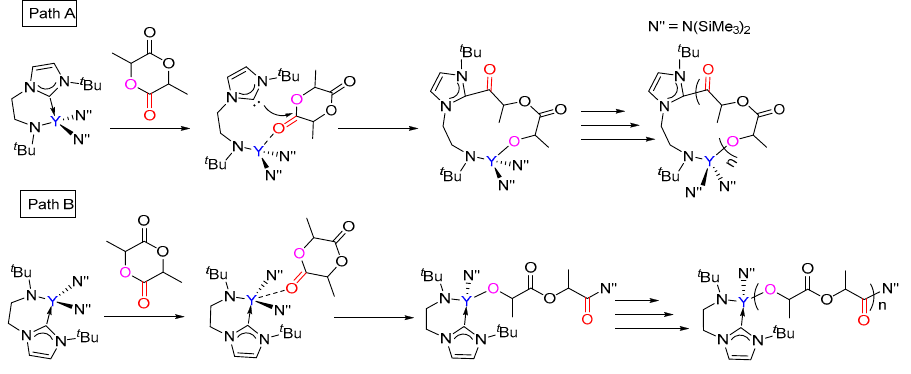
Figure 1. Calculated free energy profile for the chain initiation of the ROP of rac -lactide along path A. TS 1a-2a , nucleophilic addition transition state; TS 2a-3a , ring-opening transition state. Unlike that in path A, the coordination complex of the monomer with the catalyst was not found on the energy profile of path B, possibly due to the coordinative saturation around the metal center (Figure 2). A nucleophilic attack of one N(SiMe 3 ) 2 group on the carbonyl group of ( S , S )-lactide and